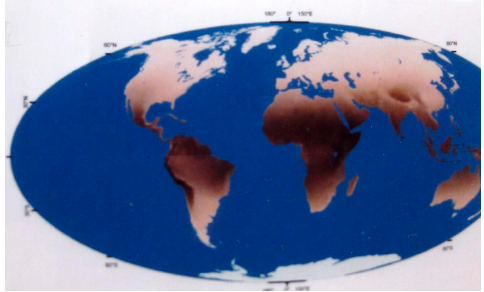
Figure 9. Global distribution of the dark-skinned population.